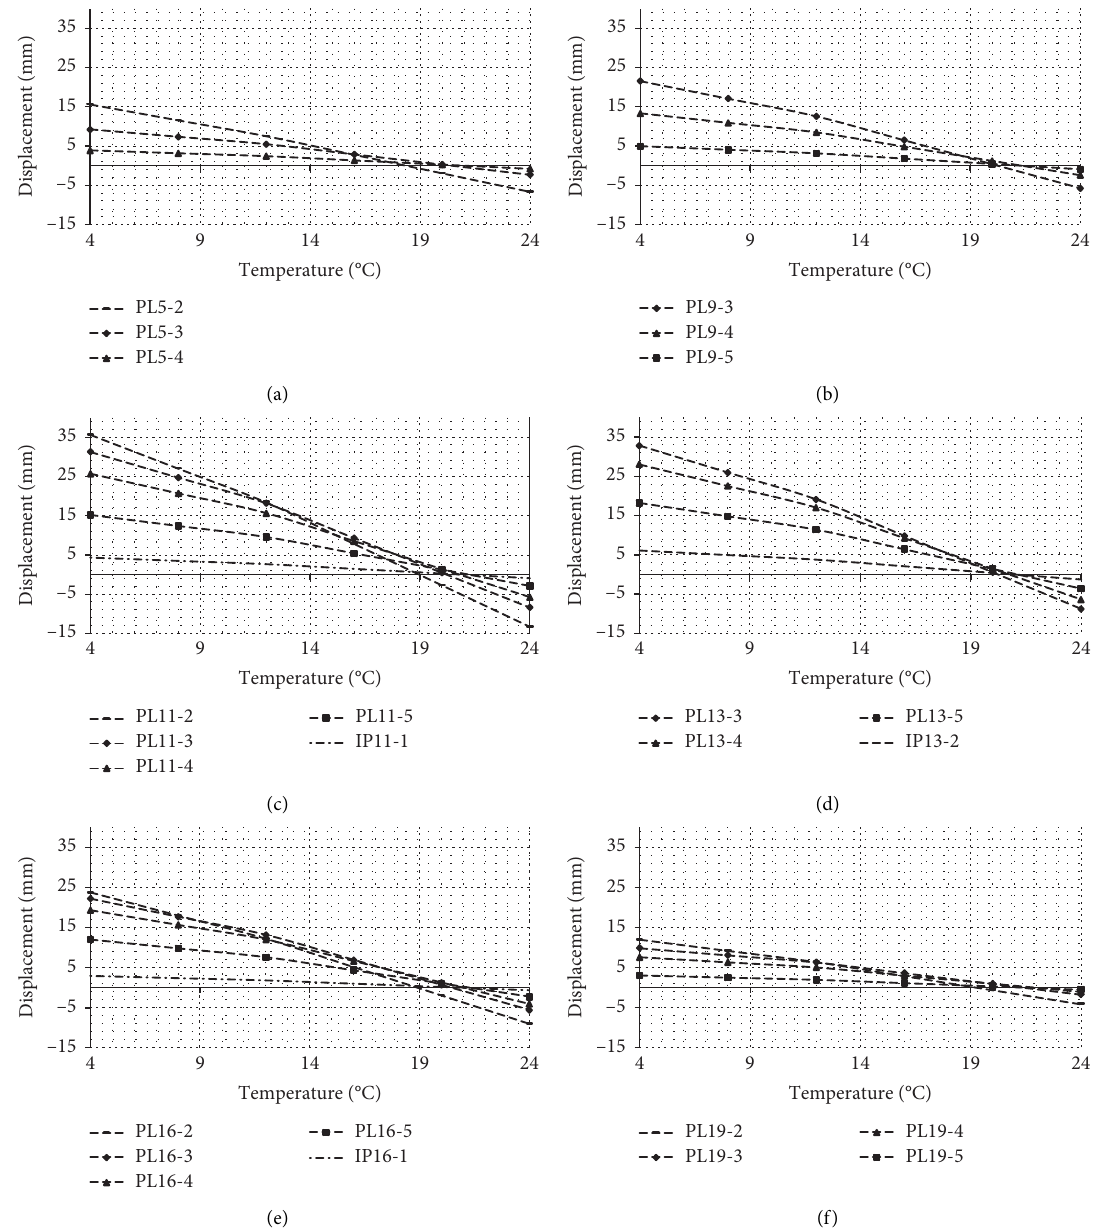
Figure 10: Variation of the radial displacement with external temperature simulated by finite element method for monitoring points located at vertical line: (a) 5#; (b) 9#; (c) 11#; (d) 13#; (e) 16#; and (f)